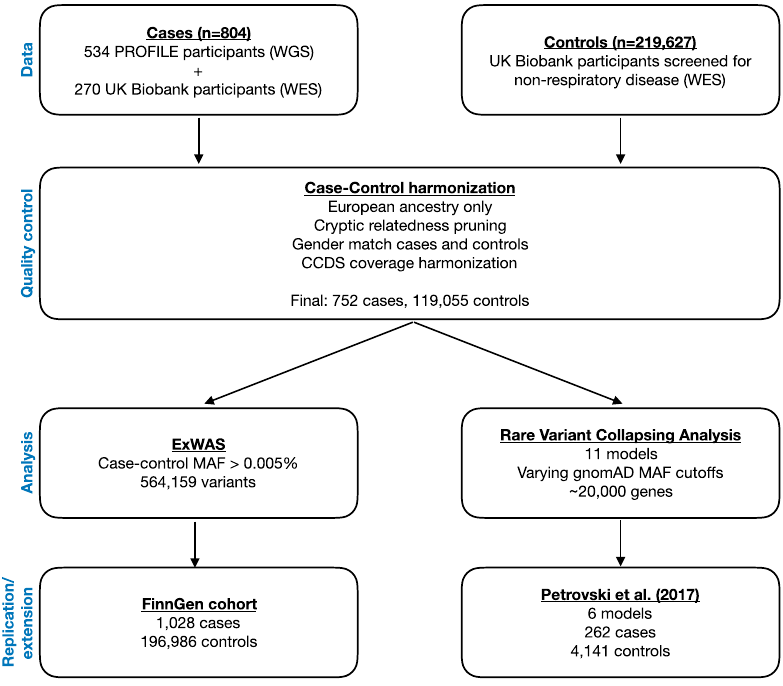
Fig. 1 Idiopathic pulmonary fi brosis genetic discovery and replication study design. We combined whole-exome sequence (WES) and whole-genome sequence (WGS) data from a total of 804 cases enroled in either the PROFILE study or the UK Biobank. Controls comprised of 219,627 UK Biobank participants. We harmonised the case-control cohort based on ancestry, relatedness, and gender, resulting in a test cohort total of 752 cases and 119,055 controls screened for non-respiratory disease. We fi ltered out sites that were differentially covered between cases and controls. We then performed two analyses: an exome-wide variant-level association test (ExWAS) and rare variant collapsing analysis. Variants from the ExWAS with p < 0.01 were then reviewed in the FinnGen cohort. Collapsing analyses were also combined with previously published results from an independent case-control study 6 . MAF = minor allele